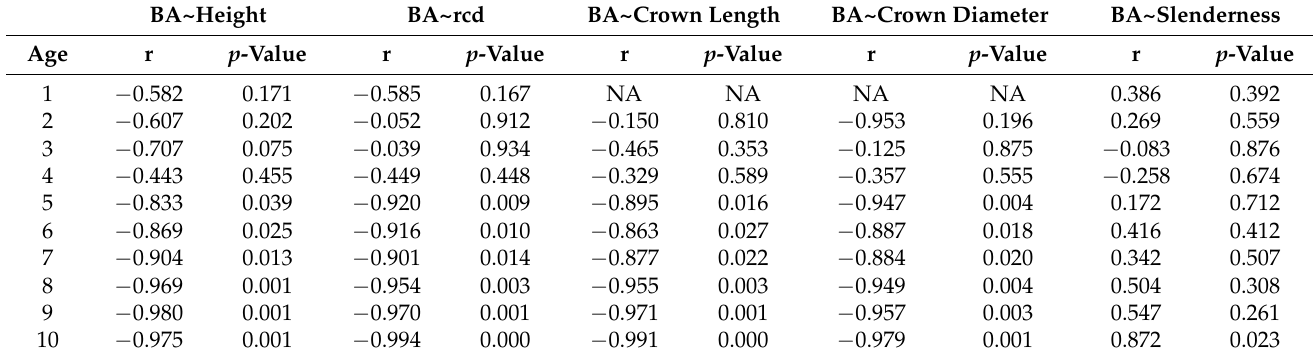
Table 4. Results of Pearson’s correlation analyses of overstorey trees (basal area (BA), m 2 /ha) and in cm, crown diameter in